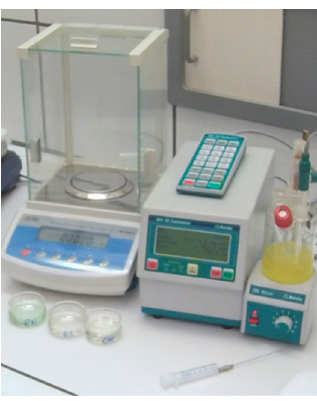
Figure 4. Measurement setup used for drying pressboard samples by means of synthetic ester.